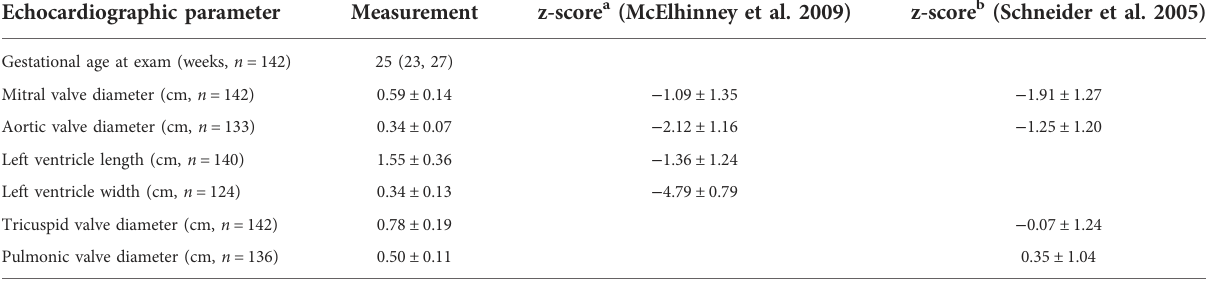
TABLE 1 Fetal echocardiographic parameters from fetuses with left CDH with z-scores from published equations derived from unaffected fetuses. Echocardiographic parameter